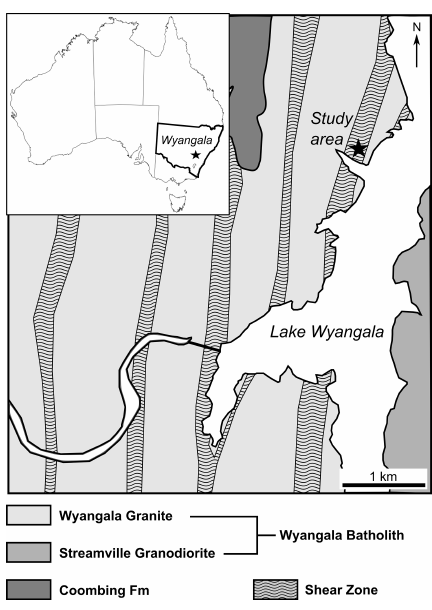
Figure 1. Locality map showing the position of Wyangala area in a regional context (inset) and the location of the studied outcrop on a simplified geological map (modified after Czarnota,